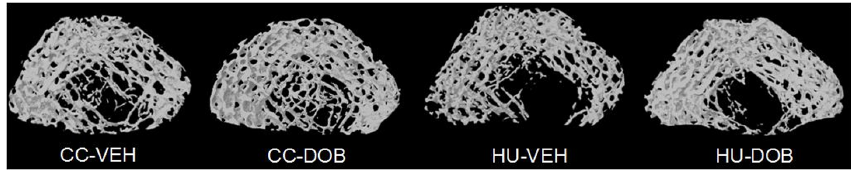
Figure 2. Representative three-dimensional mCT images of the distal femur metaphysis cancellous bone in dobutamine- (DOB) or vehicle- (VEH) treated rodents during hindlimb unloading (HU) or ambulatory cage activity (CC).